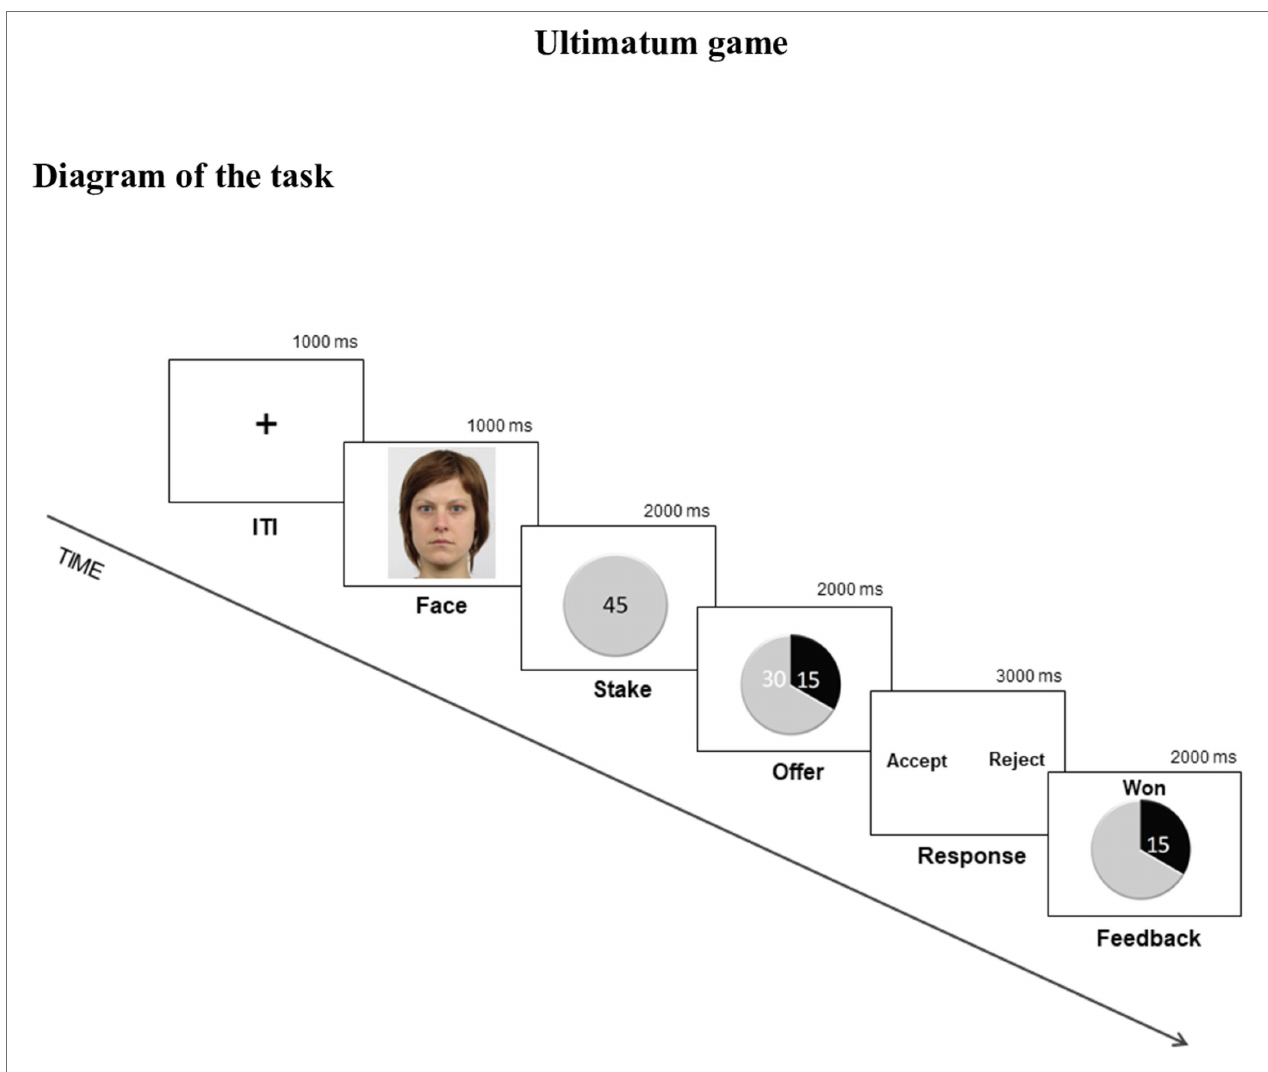
FIGURE 1 | Schematic representation of one round of the Ultimatum Game (UG; dark-gray portion = respondent; light-gray portion = proposer); ITI, intertrial interval. Figure reproduced with permission from the Radboud Faces Database (RaFD).